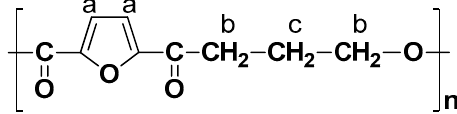
Scheme 2. PPF structure and 1 H-NMR peak assignments.